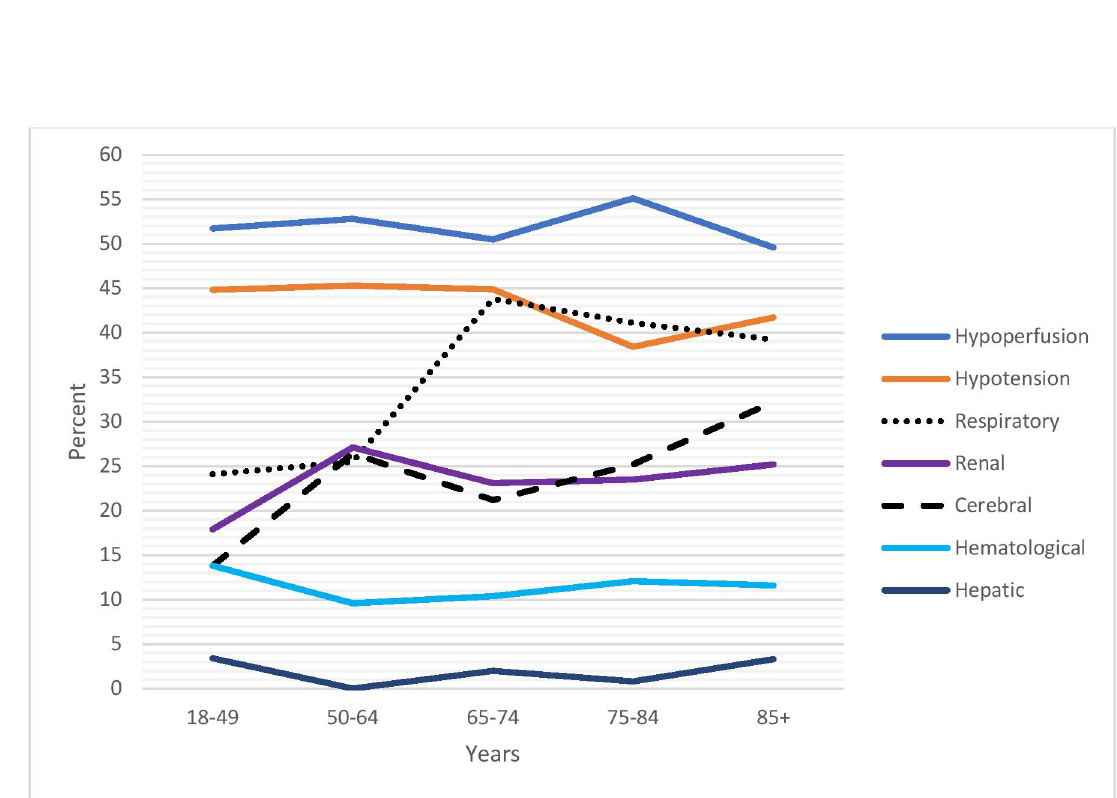
Fig 5. Organ dysfunction rates in 482 episodes with severe sepsis, classified according to age group.